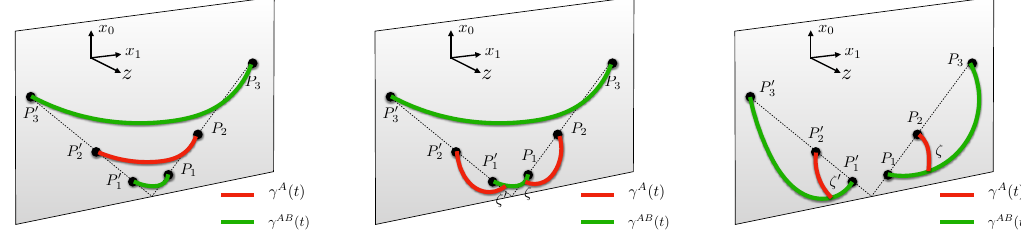
Figure 25 . Phases for geodesics (cid:13) AB ( t ) (green) and (cid:13) A ( t ) (red) in the (unwrapped) two-sided BTZ black hole, mapped into circles of an AdS 3 poincare